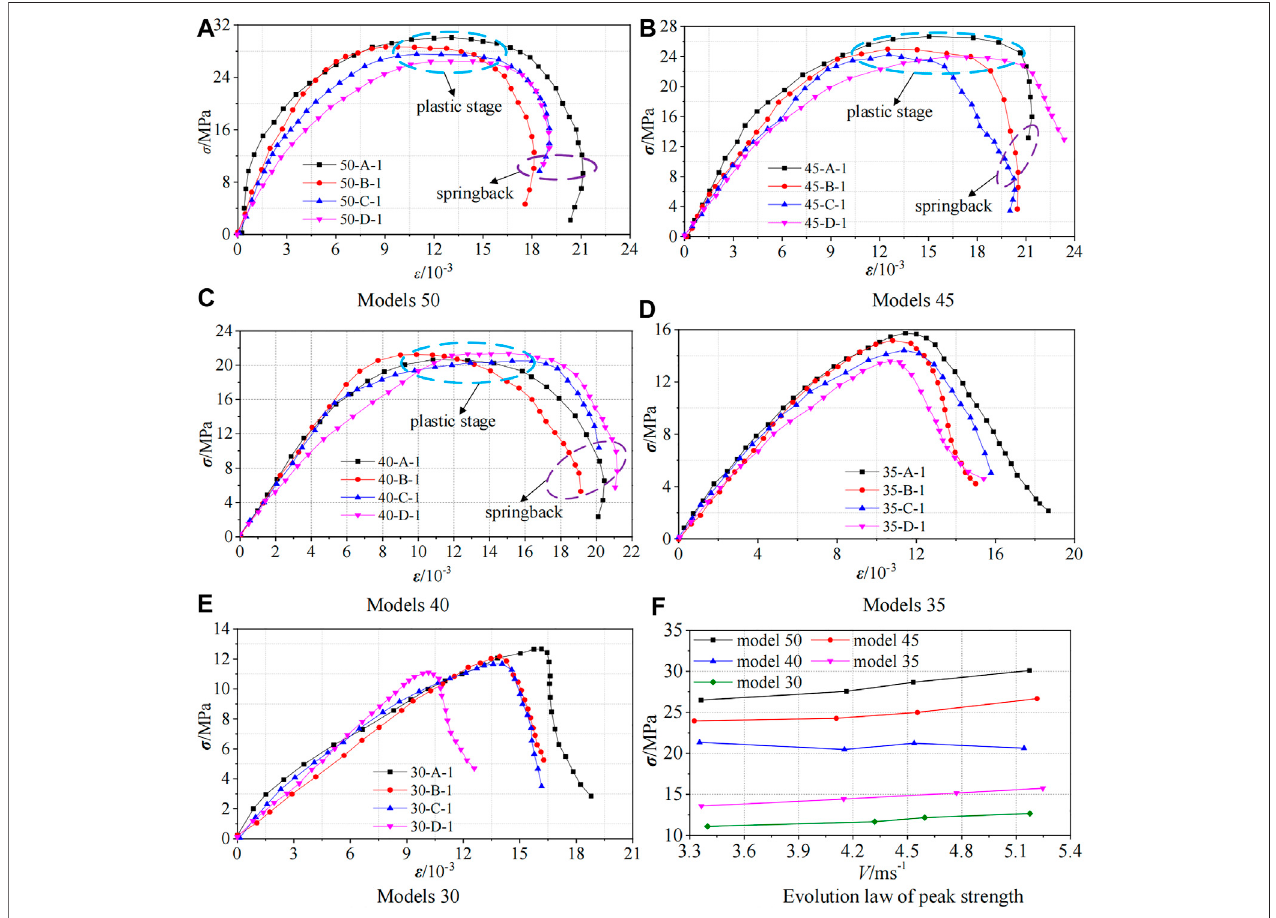
FIGURE 8 | (A – E) Strength evolution of specimens under different dynamic loads without pre-static load; (F) Evolution law of peak strength of each